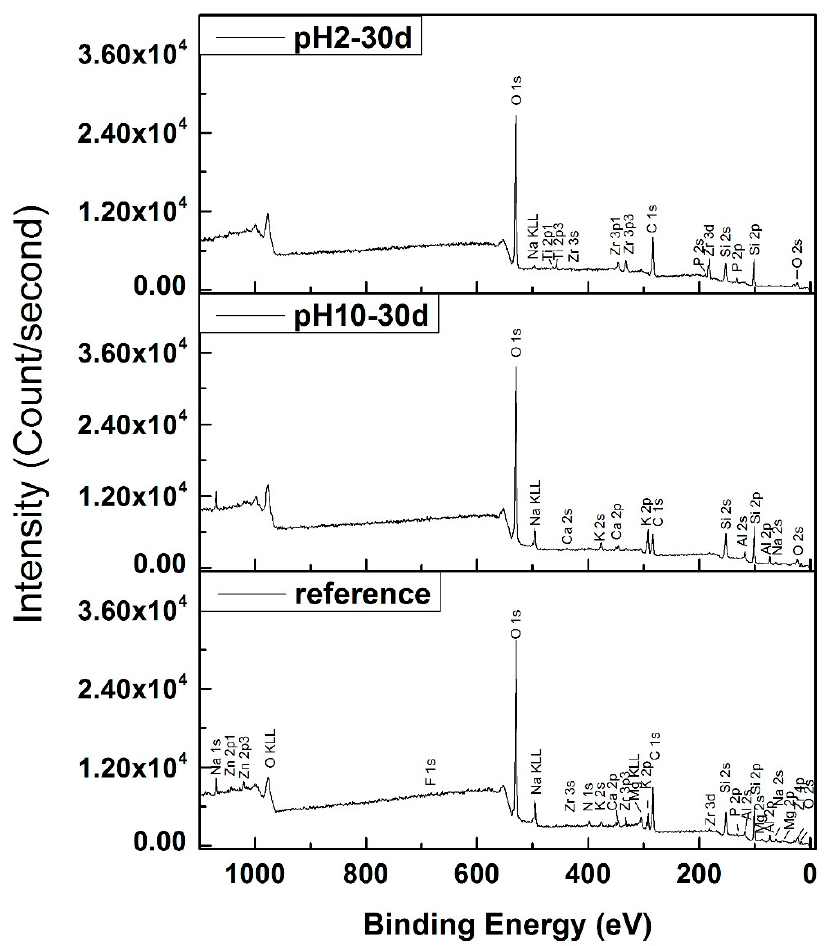
Figure 3. The X-ray photoelectron spectroscopy (XPS) survey for reference, corroded disks in pH 10 and pH 2 after 30 days. Table 2. The composition of reference, corroded pH 10 disks, and corroded pH 2 disks after 30 days.